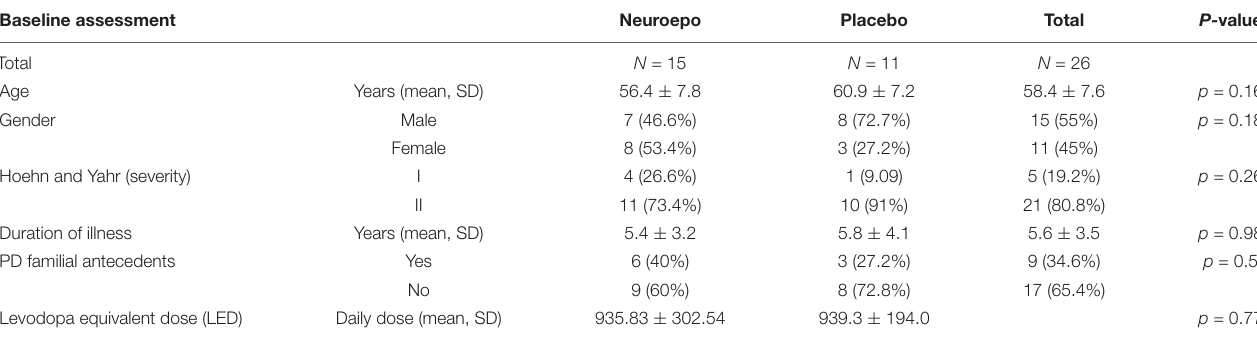
TABLE 1 | Clinical and demographic characteristics of the